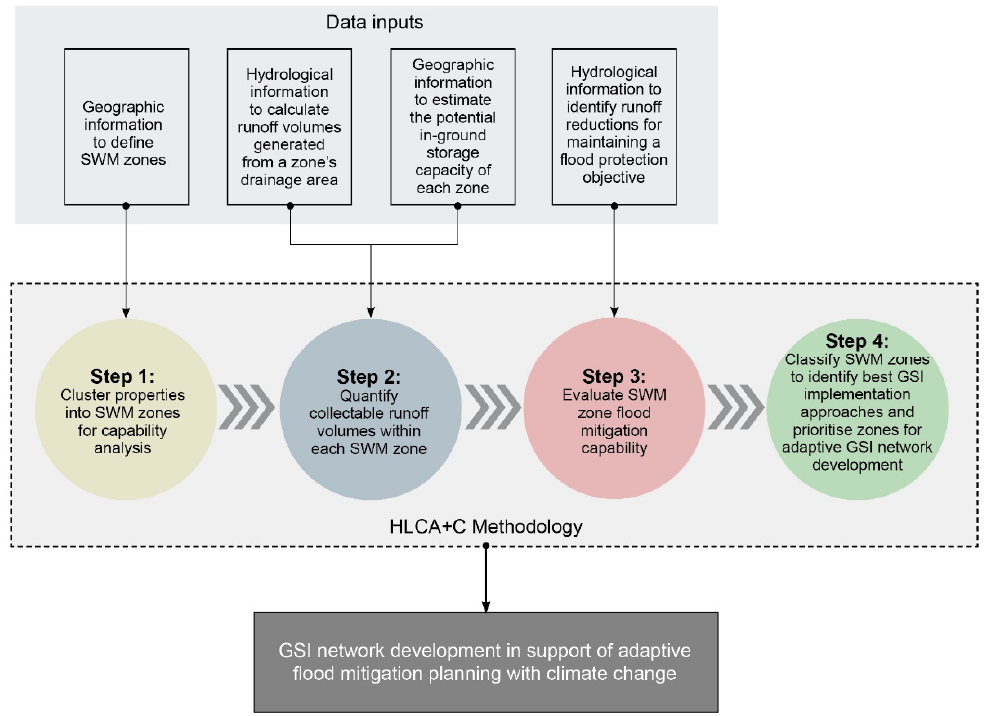
Figure 2. The four steps of the Hydrology-based Land Capability Assessment and Classification methodology (HLCA+C). The methodology evaluates and classifies SWM zones to prioritise flood mitigation zones and evaluate implementation approaches toward effective GSI networks through time with increased climate change impacts.